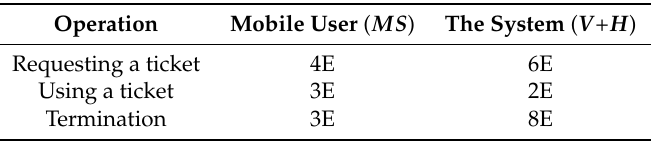
Table 2. Computation